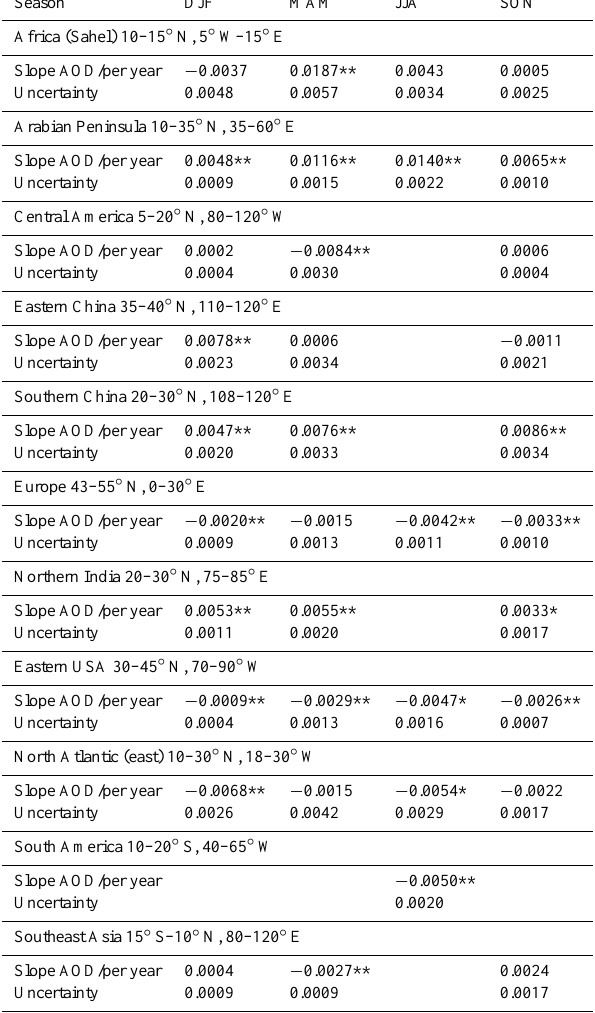
Table 3. Seasonal trends derived based upon 13-yr SeaWiFS AOD products (January 1998–December 2010) for the same sub-regions as in Table 1. The corresponding uncertainties are the 68% con- fidence limit. ** indicates trends significant at 95%, * indicates trends significant at 90%. Blank cells represent regions with insuf- ficient sampling sizes for trend calculations within a given season.